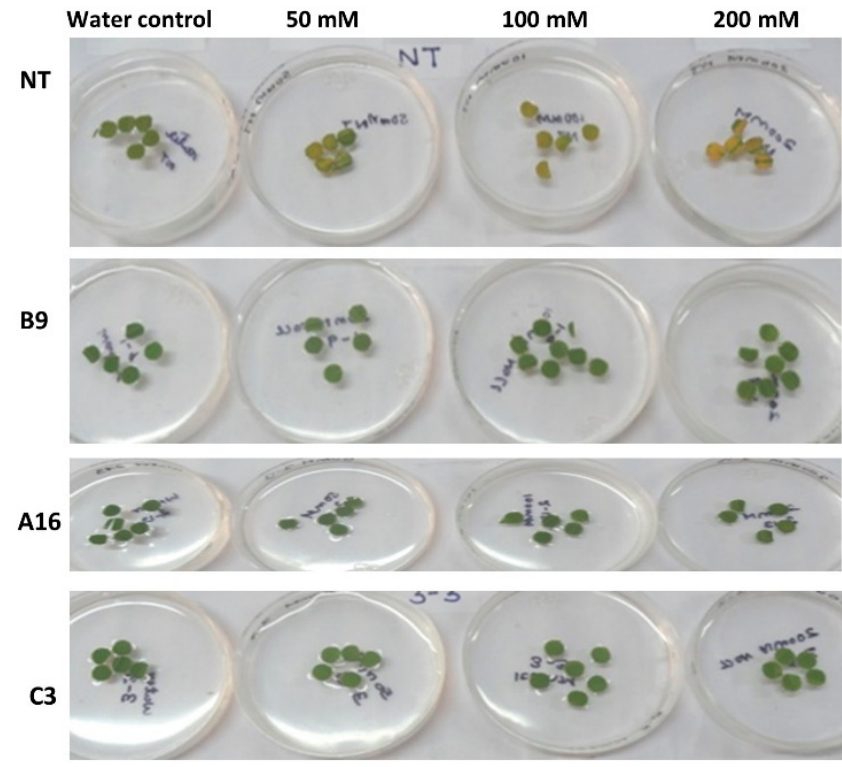
Figure 7. Chlorophyll stability assay in the leaf discs of non-transgenic (NT) and transgenic ADT 43 (T 1 ) lines at various levels of NaCl stress .